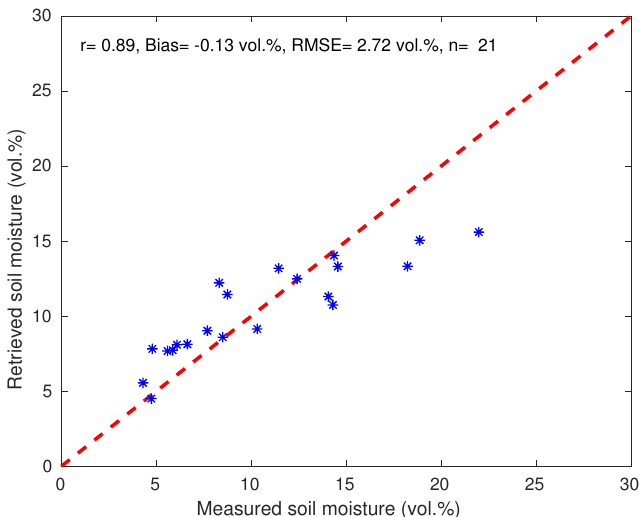
Figure 9. Comparison between retrieved soil moisture using support vector machine and ground- truth measurements.